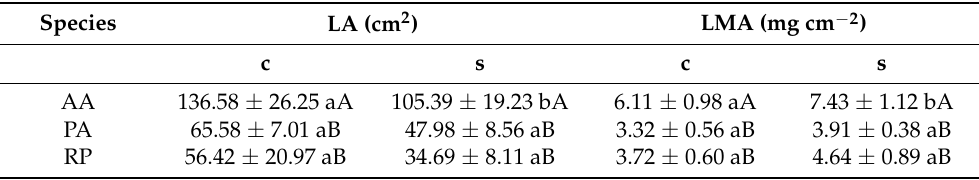
Table 2. Leaf morphology of Ailanthus altissima (AA), Phytolacca americana (PA), and Robinia pseudoa- cacia (RP) between the control seedling (c) and stressed seedling (s). Leaf area (LA) and leaf mass per area (LMA). Lowercase letters indicate differences within species, and capital letters indicate differences among species. Mean ± standard deviation with the same letter is not significantly different (ANOVA, p ≤ 0.005).